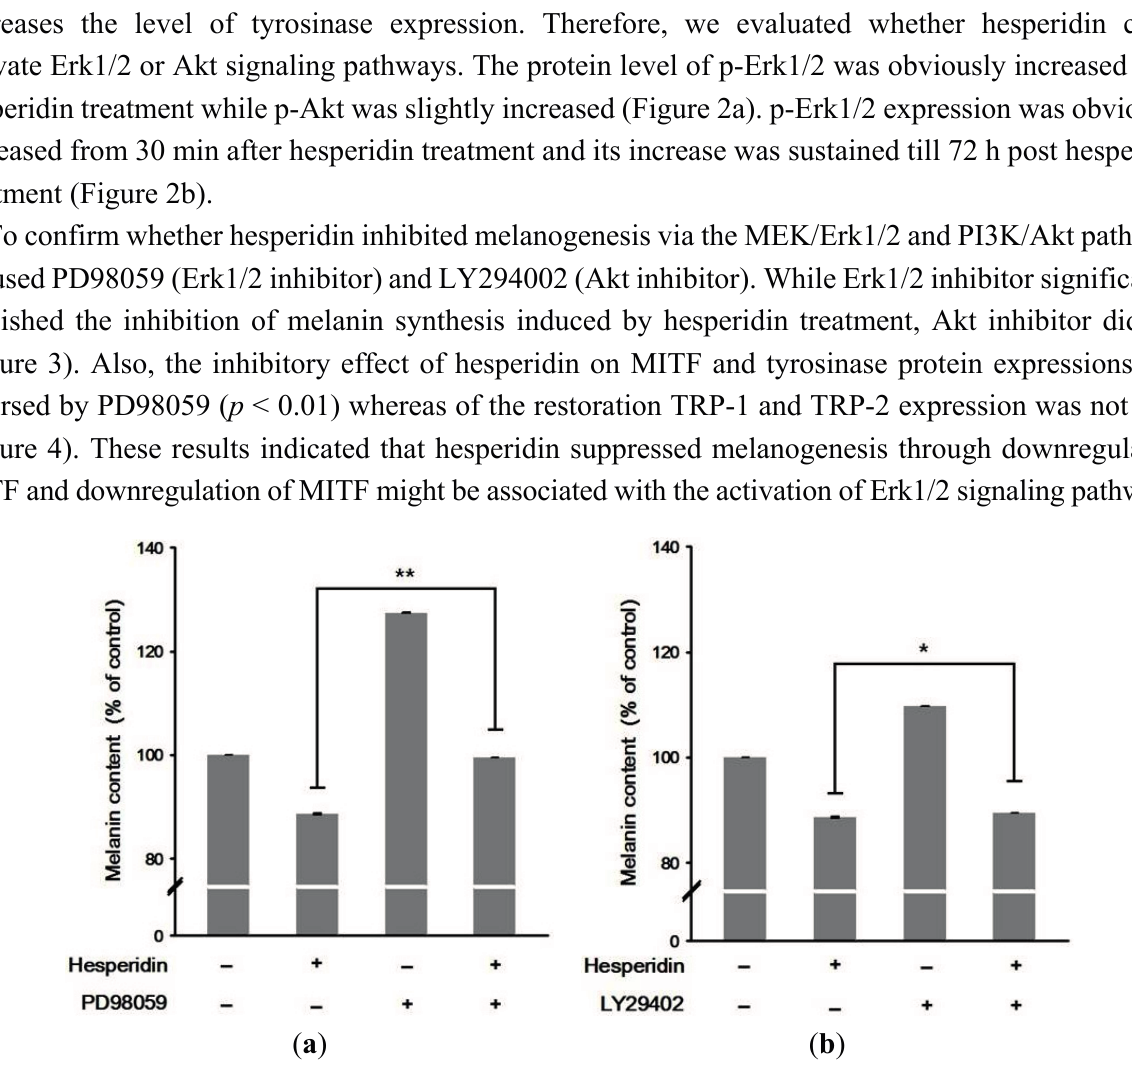
Figure 3. Effect of co-treatment with ( a ) Erk1/2 inhibitor (PD98059) or ( b ) Akt inhibitor (LY29402) in the presence of hesperidin on melanin contents in B16F10 cells. Cells were incubated with Erk1/2 inhibitor PD98059 or Akt inhibitor LY294002 with or without hesperidin. Each percentage value for the treated cells was reported relative to that in α -MSH-stimulated cells (negative control). Data were expressed as mean ± SD of three independent experiments carried out in triplicates. * p < 0.05; ** p < 0.01 as compared to the one treated with hesperidin (30 μ M)